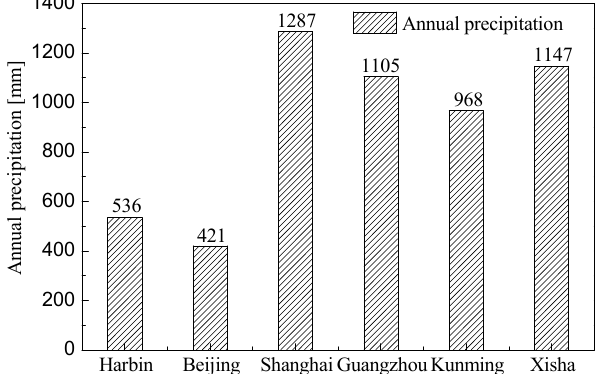
Figure 10. Annual precipitation of different representative cities.